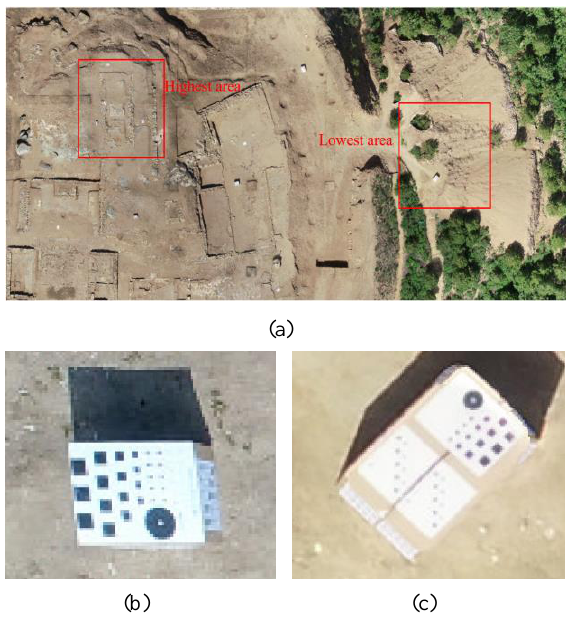
Figure 6. Comparison of the results of the highest model (b) and the lowest area (c) identification model in the site area